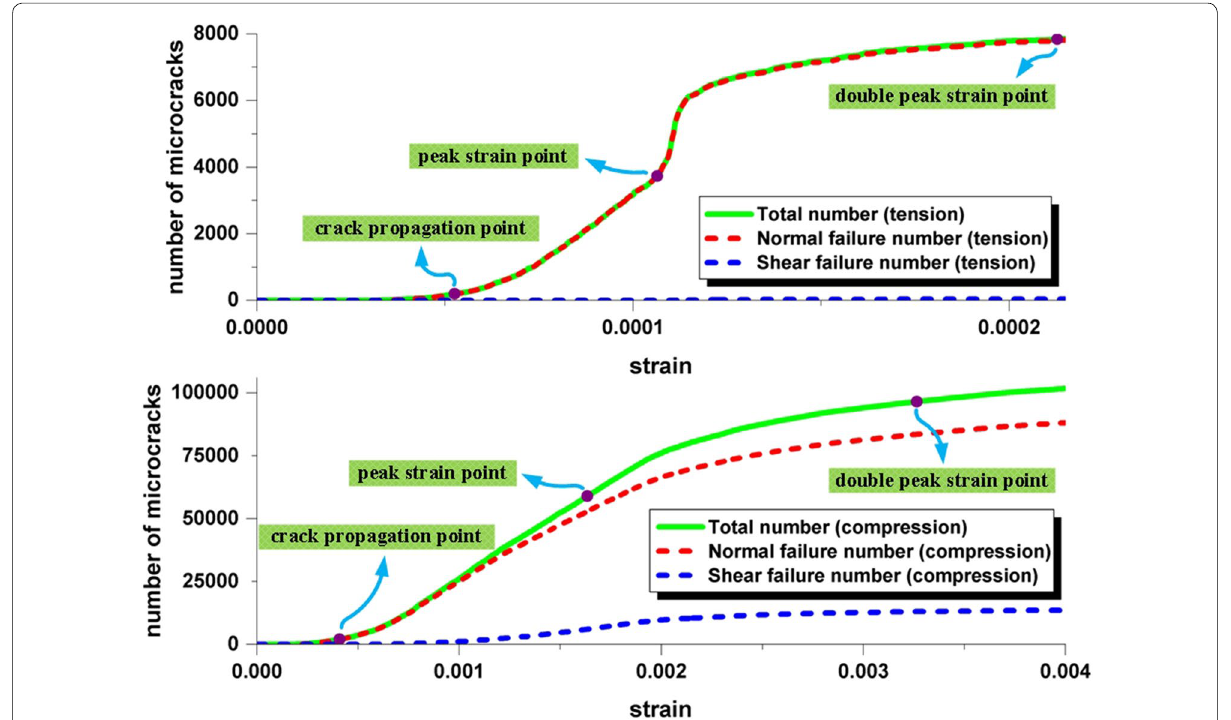
Fig. 11 Number of microcracks (broken bonds) versus axial